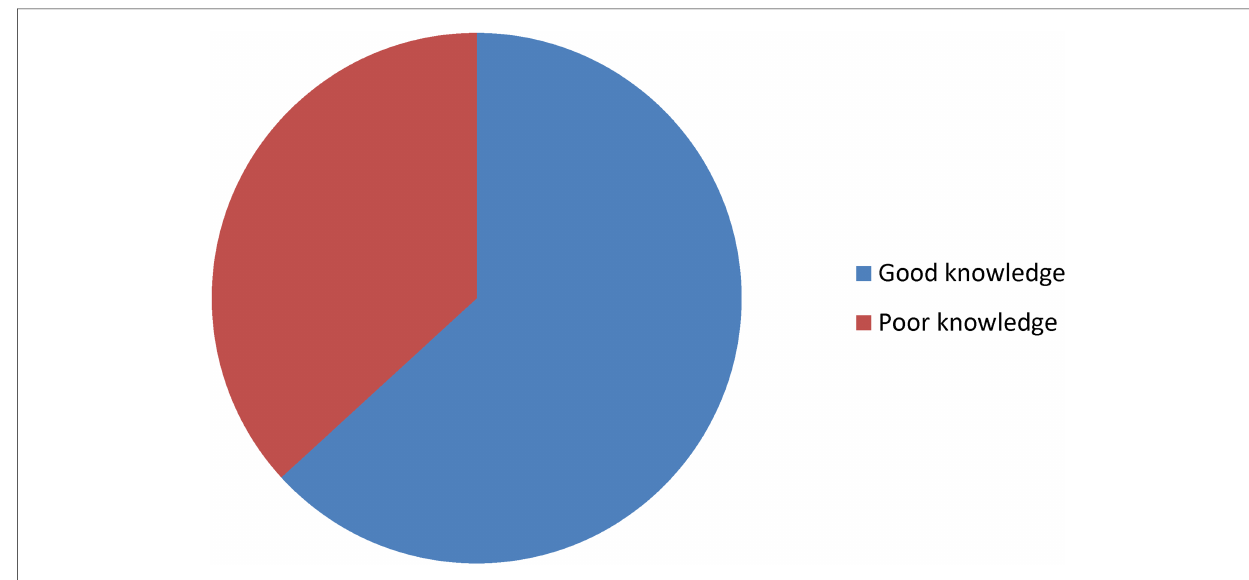
FIGURE 1 Prevalence of knowledge of pregnancy danger